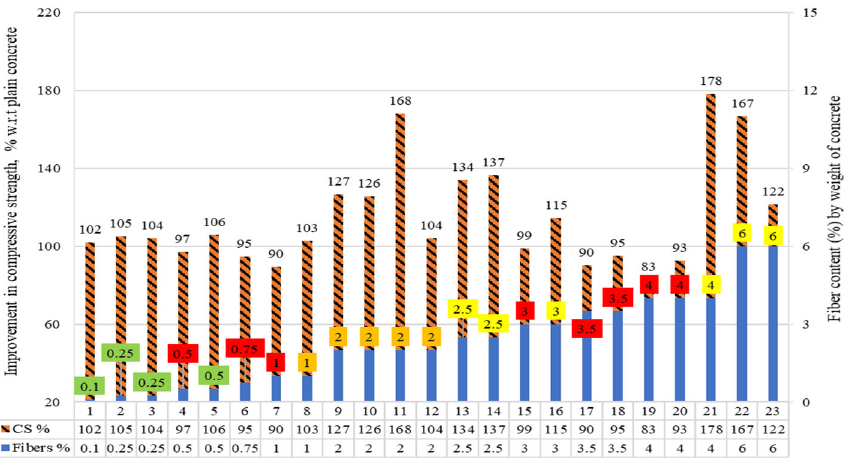
Figure 6. Percentage comparison of the compressive strengths of concrete containing RSF by its weight fraction. weight